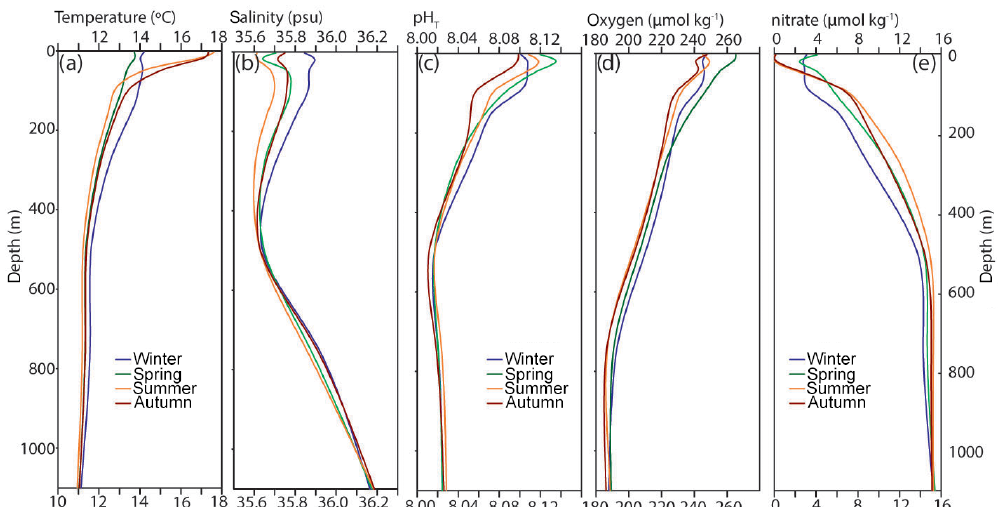
Figure 3. Profiles of seasonal means of temperature (a) , salinity (b) , pH T (c) , oxygen (d) and nitrate concentration (e) in the first 1100m of the region South Ocean shown in Fig.